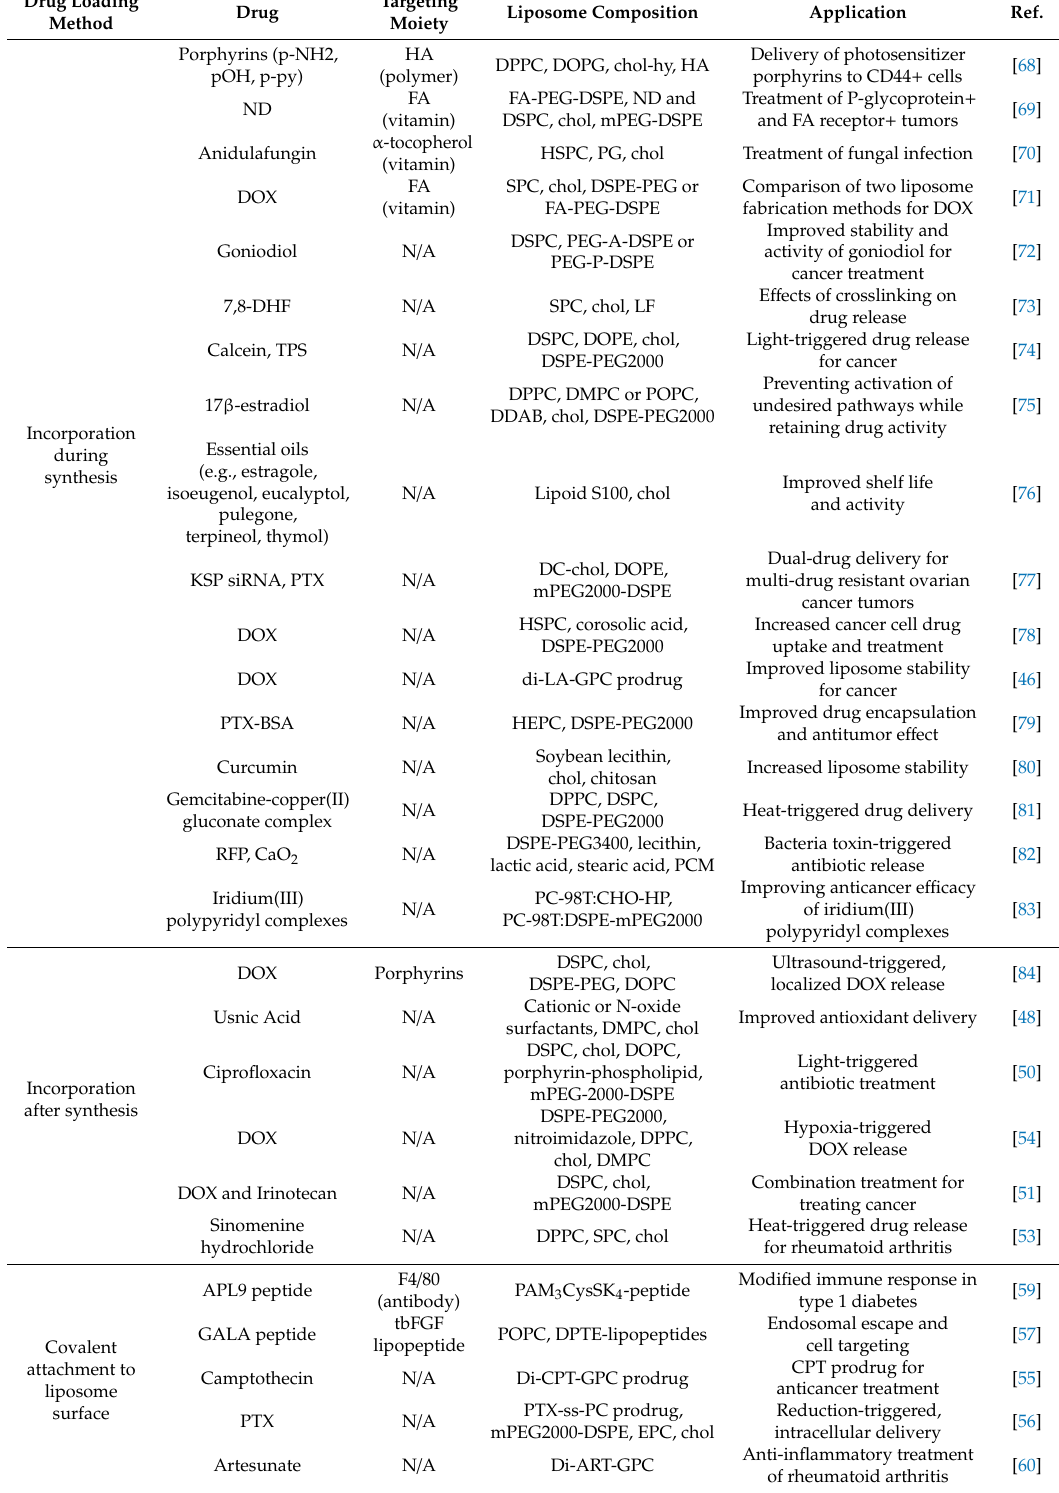
Table 1. Examples of liposomes in literature from 2018 to 2020 using bioconjugation strategies for drug encapsulation and